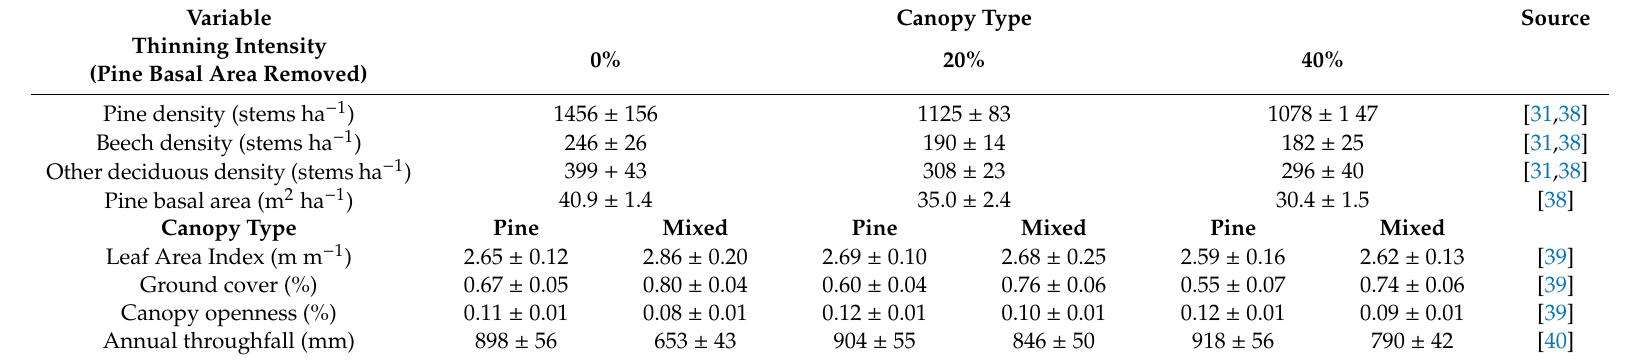
Table 2. Environmental variables in each thinning intensity and canopy